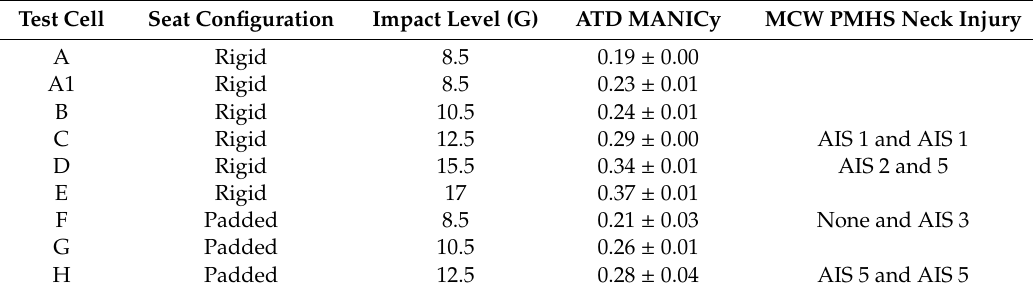
Table 3. Neck injury risk for seat